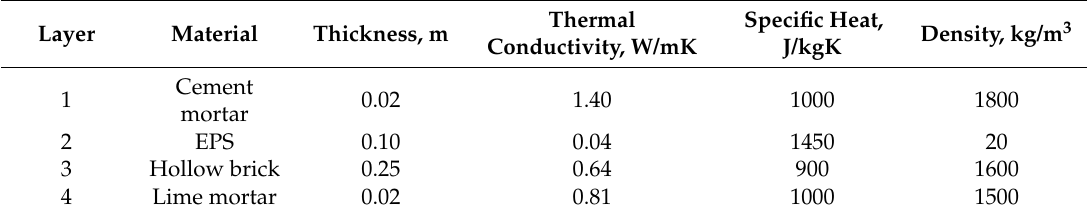
Table 2. Thermo-physical properties of outer